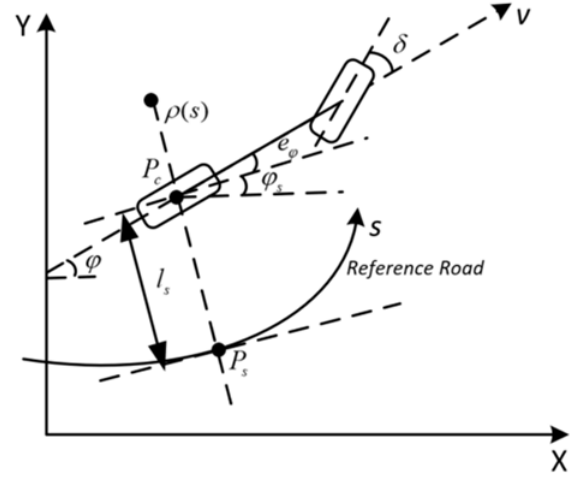
Figure 2. Vehicle kinematic model along the road coordinates.